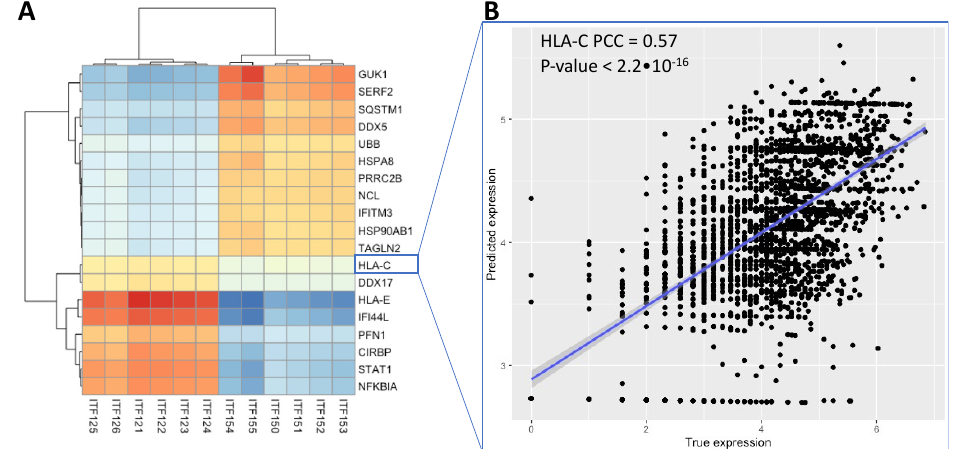
Figure 5. Results for predicting expression levels of TAGs using machine learning models. ( A ) Correlation between TAG expression and ITFs. ( B ) Prediction of MHC-I (HLA-C) expression using an LightGBM model trained on the 12 ITFs in ( A ).